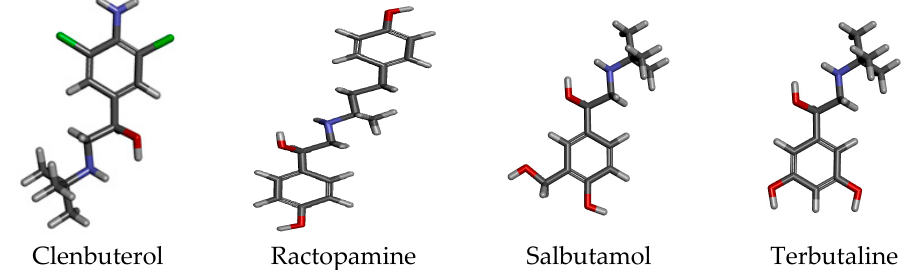
Figure 1. Structures of the four β 2 -agonists. Red is O, blue is N, green Cl, black C, grey H.